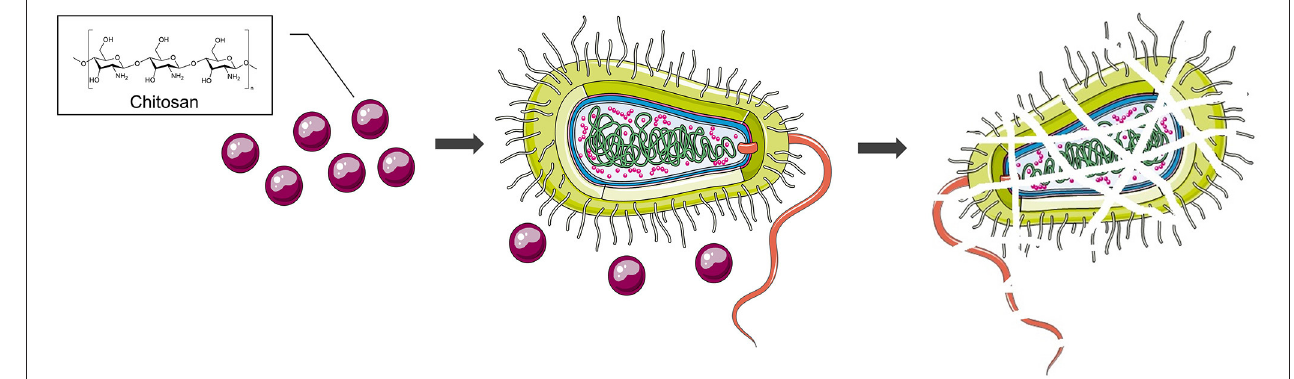
FIGURE 5 | Inhibition of bacterial activity by